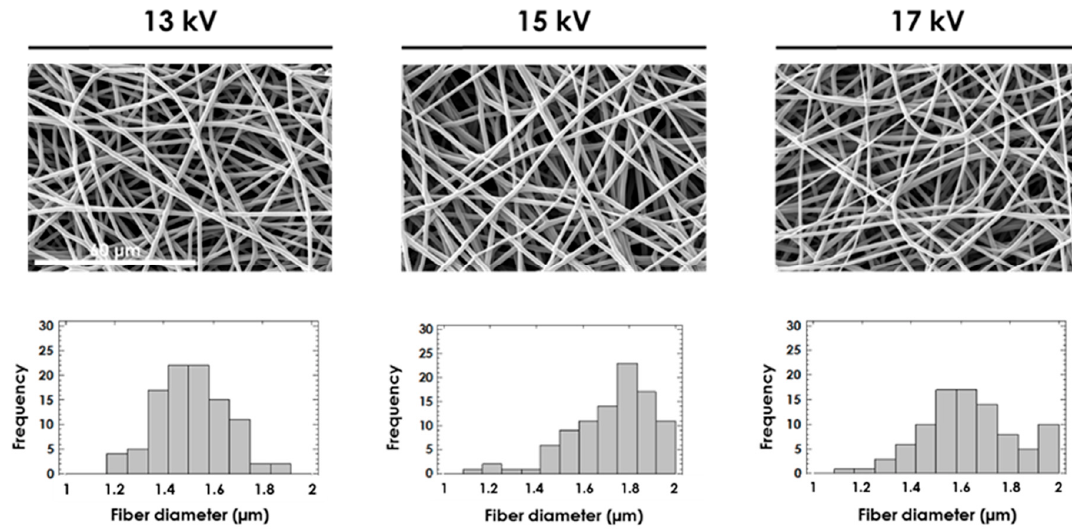
Figure 4. SEM images and histograms of the fiber diameter for 25% w/v PLGA in HFIP at 13 kV, 15 kV and 17 kV by maintaining flow rate = 2 mL/h and distance from needle to collector = 13 cm. All images share the same scale bar: 60 μ m.